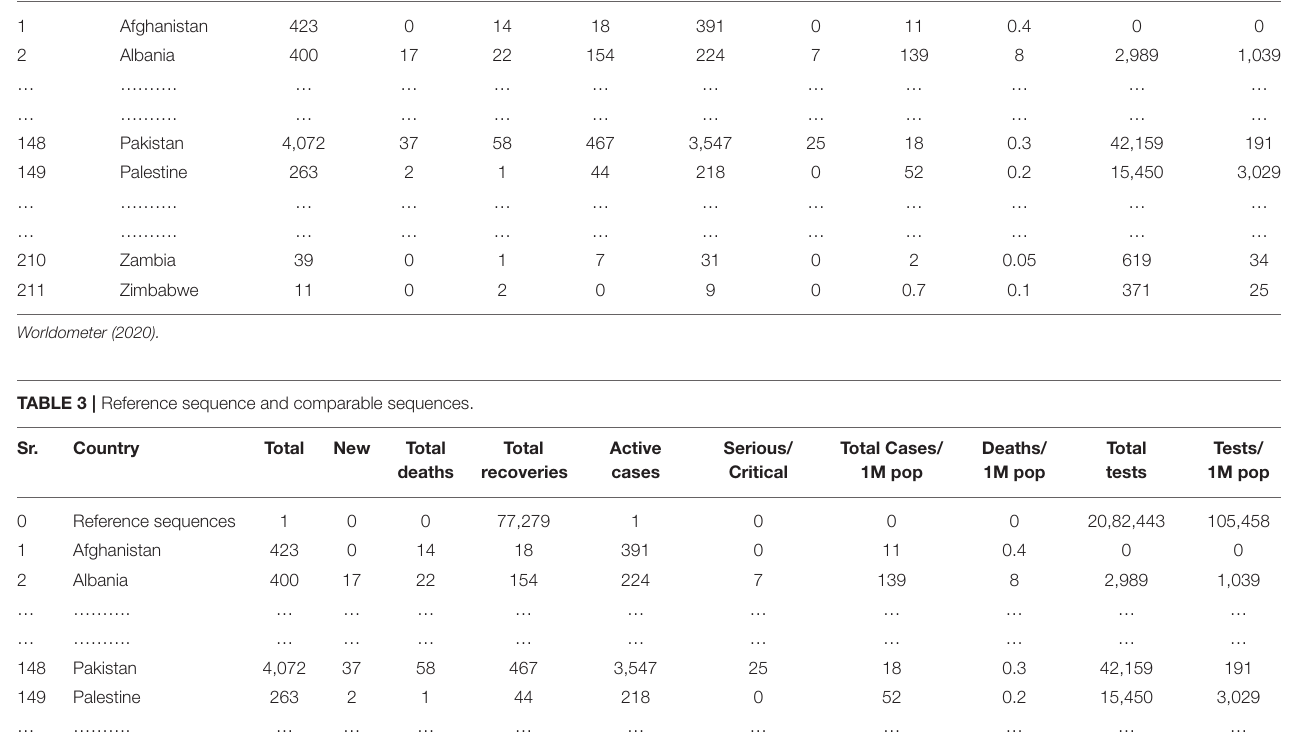
TABLE 2 | Original country wide data set on corona virus. Sr.